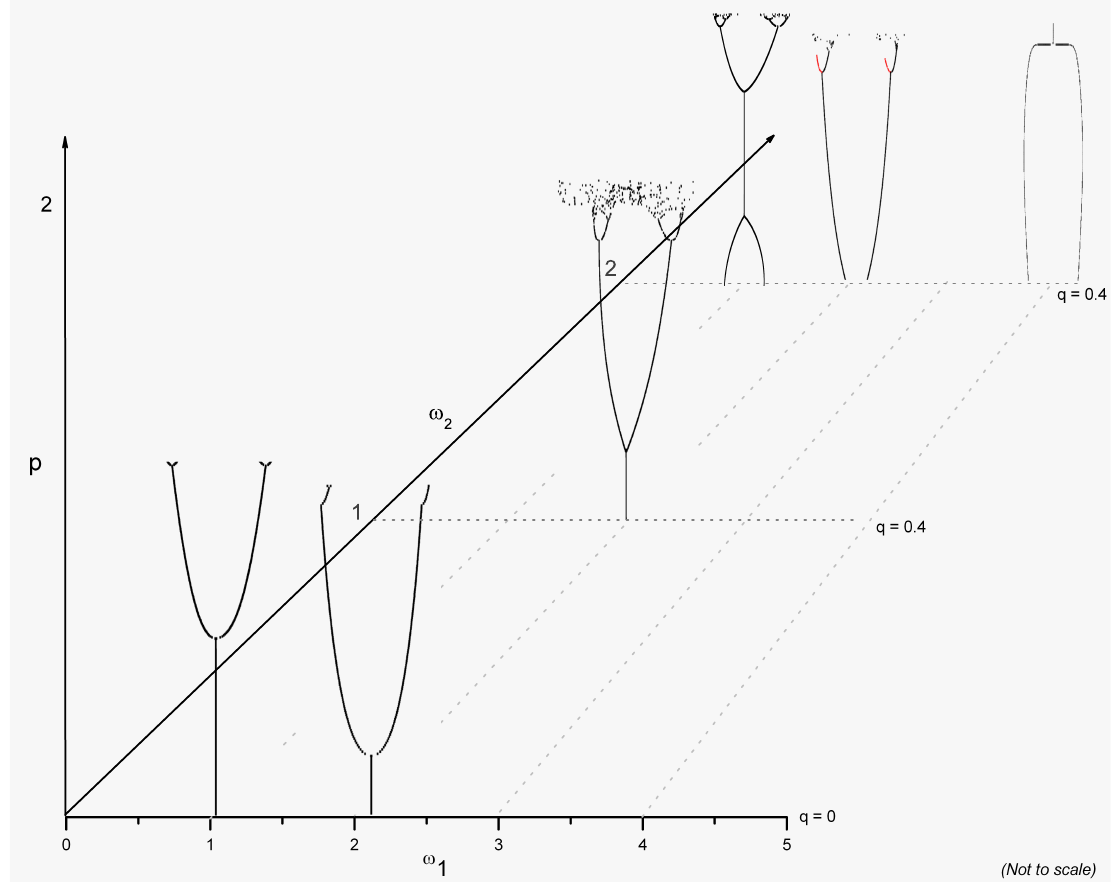
Figure 3. Three-dimensional plot portraying a combination of bifurcation diagrams for certain frequency ratios under the parameter conditions β excitation amplitudes are as stated on the